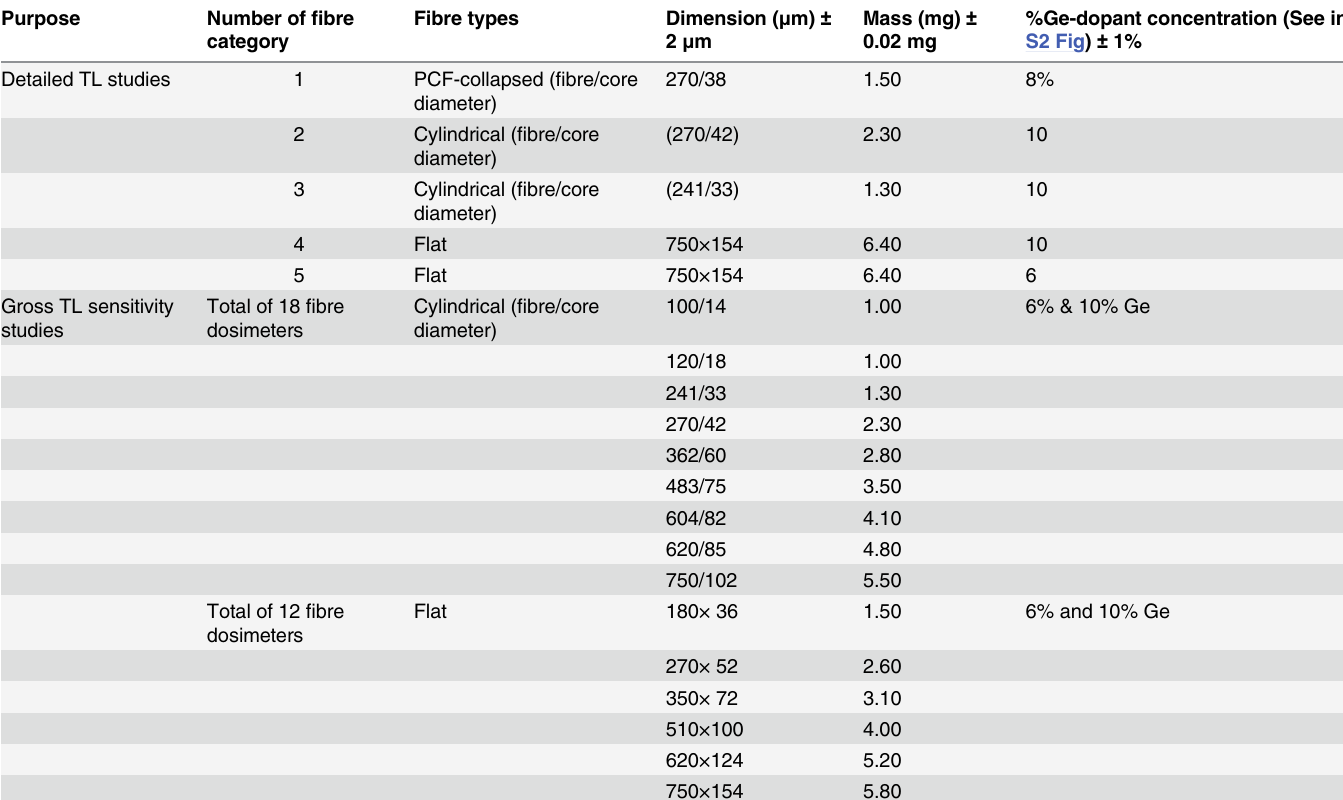
Table 1. Details of all types of silica based optical fibres used in study of various TL properties.